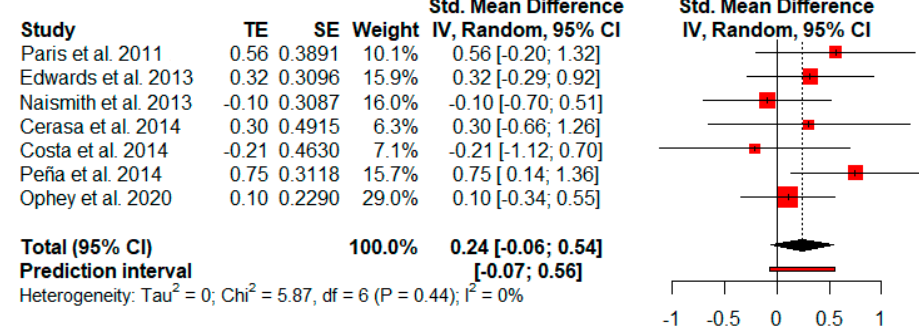
Figure 11 . Effectiveness of cognitive rehabilitation in processing speed.